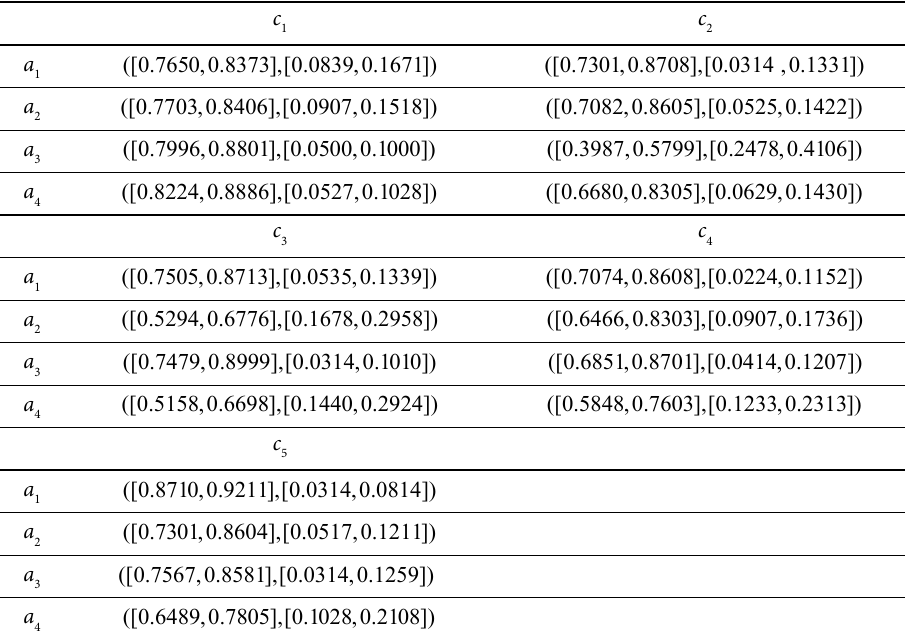
Table 9. Collective interval-valued intuitionistic fuzzy decision matrix of